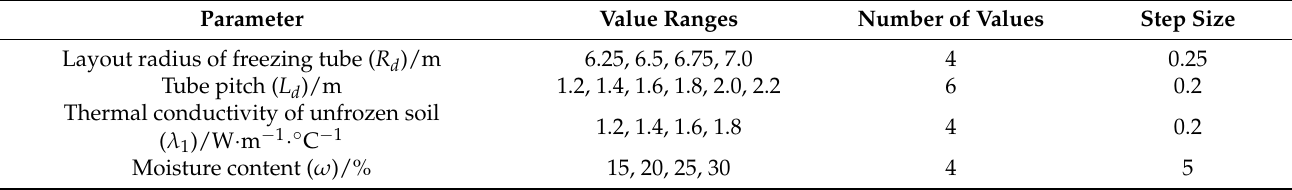
Table 4. Value ranges of each parameter in the full combination calculation.